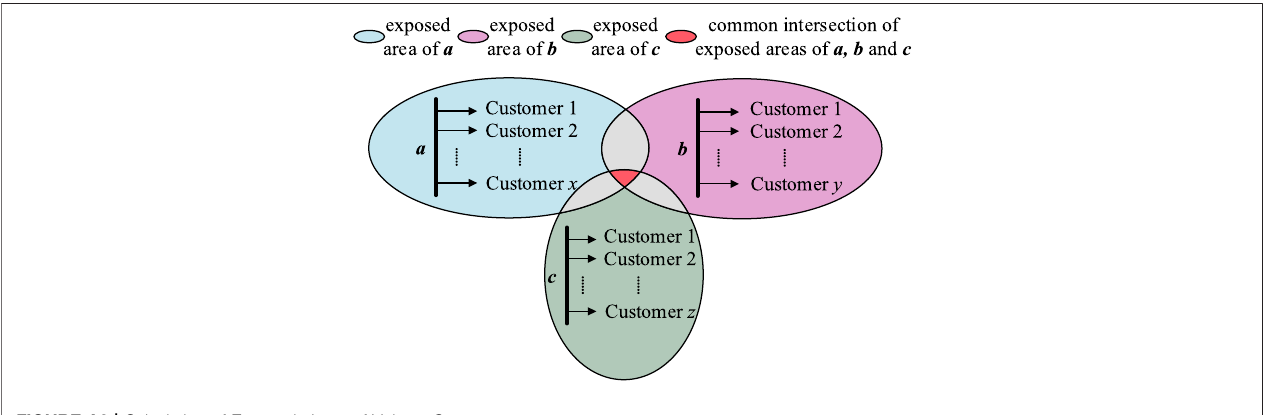
FIGURE A3 | Calculation of Economic Loss of Voltage Sag.